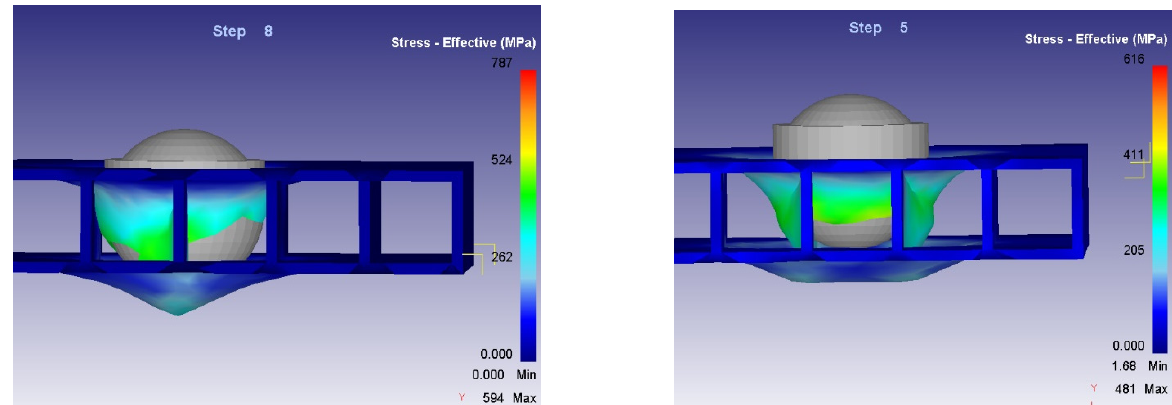
Figure 13 . Stress-effective efforts of the structure in the two considered cases . Figure 13. Stress-effective efforts of the structure in the two considered